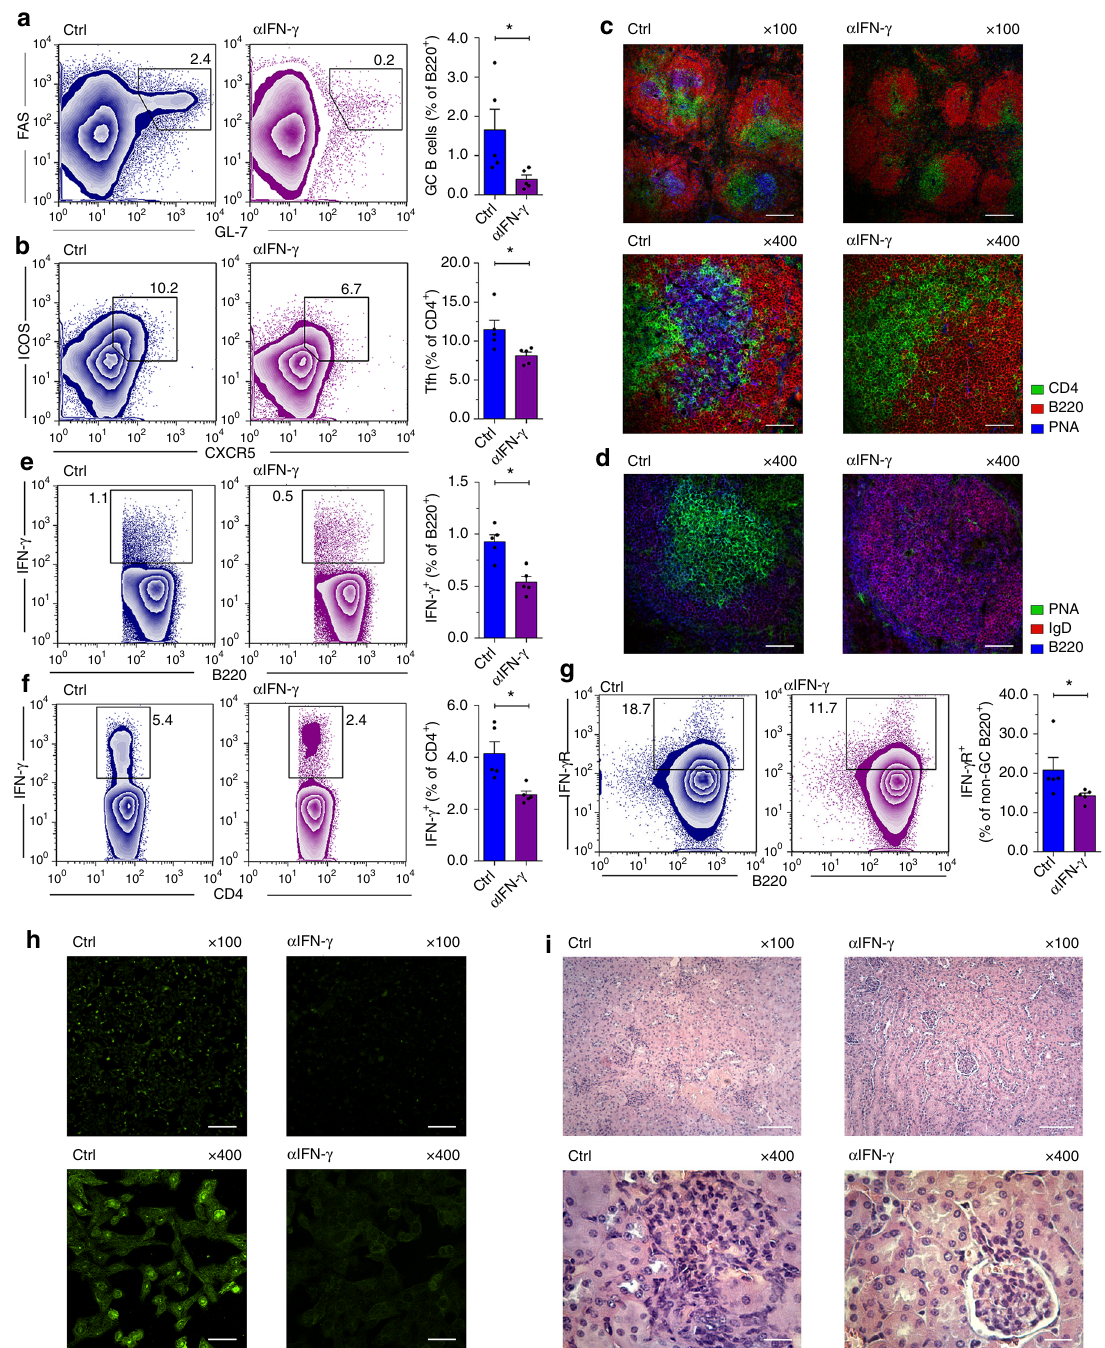
Fig. 6 IFN- γ signaling blockade prevents spontaneous GC formation and lupus-like disease. a , b Representative plots and statistical analysis of the frequency of GC B cells and Tfh cells in the spleen of Ig-control Gal-3 KO (Ctrl) and anti-IFN- γ -treated Gal-3 KO mice ( α IFN- γ ), respectively ( n = 5 for each group). c Immuno fl uorescence of frozen spleen sections (7 μ m) from Ctrl and α IFN- γ mice stained with anti-CD4 (green), anti-B220 (red) and PNA (blue). Magni fi cation: ×100 (top) and ×400 (bottom) ( n = 5 for each group). Scale bar, 200 μ m (upper panels) and 50 μ m (lower panels). d Immuno fl uorescence of frozen spleen sections (7 μ m) from Ctrl and α IFN- γ mice stained with PNA (green), anti-IgD (red) and anti-B220 (blue). Magni fi cation: 4×00 ( n = 5 for each group). Scale bar, 50 μ m. e Representative plots and statistical analysis of the frequency of IFN- γ -producing B220 + cells in the spleen of Ctrl and α IFN- γ mice ( n = 5 for each group). f Representative plots and statistical analysis of the frequency of IFN- γ -producing CD4 + T cells in the spleen of Ctrl and α IFN- γ mice ( n = 5 for each group). g Representative plots and statistical analysis of the frequency of B220 + GL7 − FAS − non-GC IFN- γ R + B cells in the spleen of Ctrl and α IFN- γ mice ( n = 5 for each group). h ANA IgG determined with Hep-2 slides in sera from Ctrl and α IFN- γ mice. Magni fi cation: ×100 (top) and x400 (bottom) ( n = 5 for each group). Scale bar, 200 μ m (upper panels) and 50 μ m (lower panels). i Kidney sections from Ctrl and α IFN- γ mice stained with H&E. Magni fi cation ×100 (top) and ×400 (bottom) ( n = 5 for each group). Scale bar, 100 μ m (upper panels) and 20 μ m (lower panels). Ig- Control Gal-3 KO mice (Ctrl) are indicated in blue and α IFN- γ -treated Gal-3 KO mice ( α IFN- γ ) in violet. Data are the mean ± s.e.m. * p < 0.05 (unpaired Student ’ s t -test). a – i Data are representative of two independent